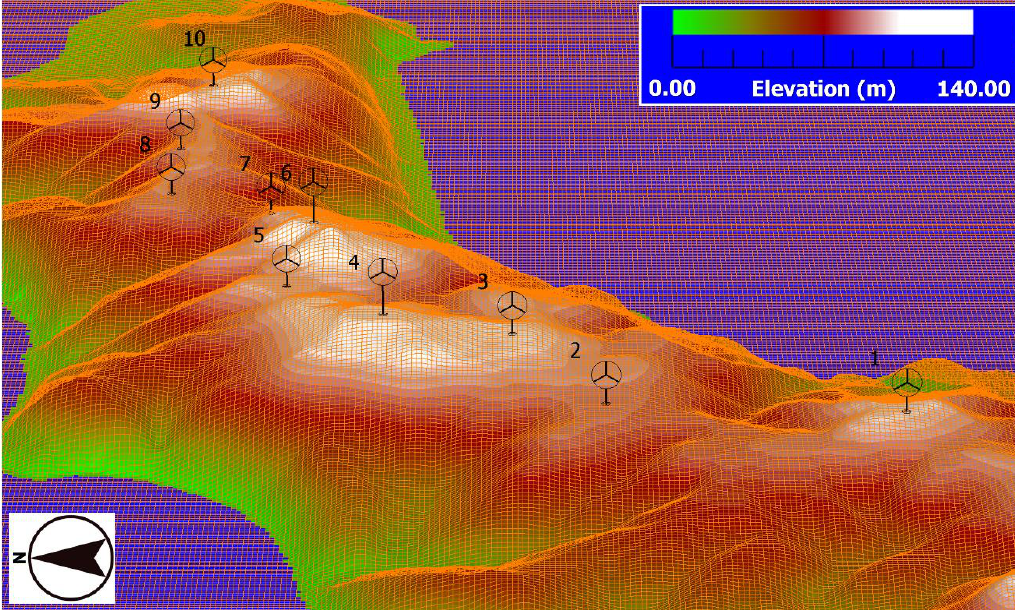
Figure 22. Smooth surface complex terrain with a horizontal grid resolution of 5 m.